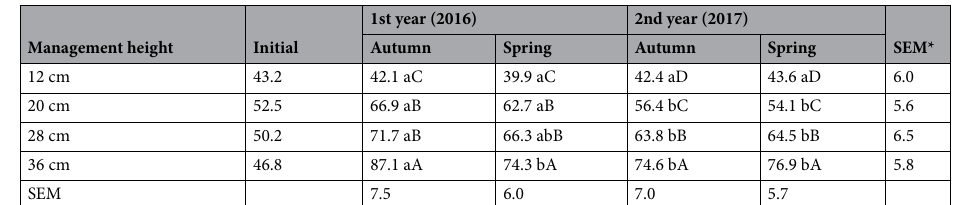
Table 3. Percentage of vegetation cover by Andropogon lateralis Nees in a natural grassland managed under different canopy heights and intermittent stocking grazing. *SEM – standard error of the mean. Means followed by the same letters in lowercase (rows) and uppercase (columns) do not differ among themselves at 5% significance.